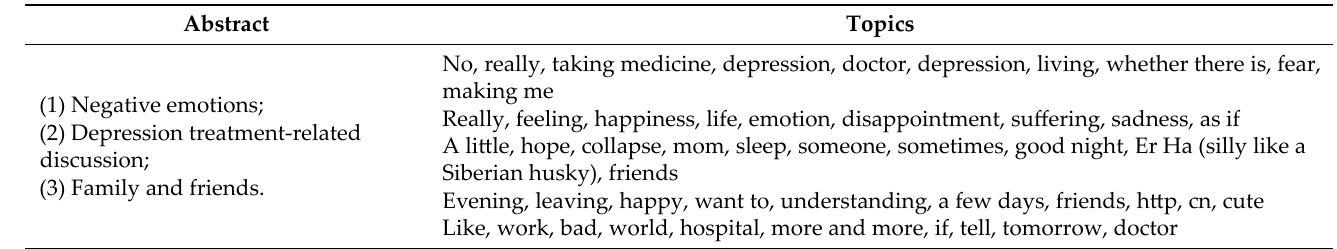
Table 5. Topics and abstract of topics for the depression super topic community (DSTC)